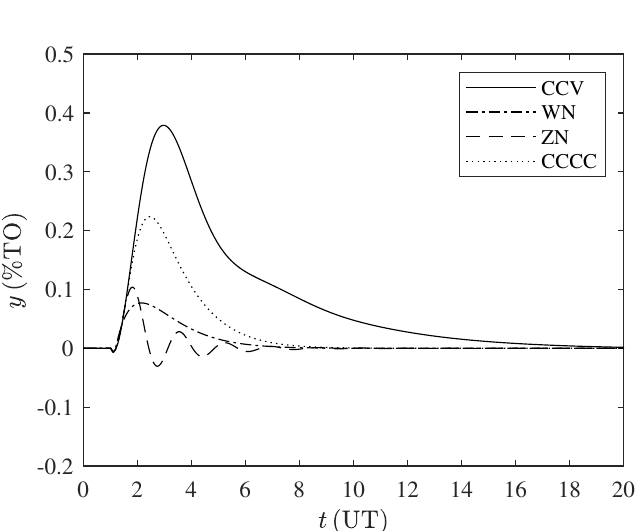
Figure A9. Time response disturbance rejection for the set P 6 . %TO: percentage of transmitter output, UT: units of